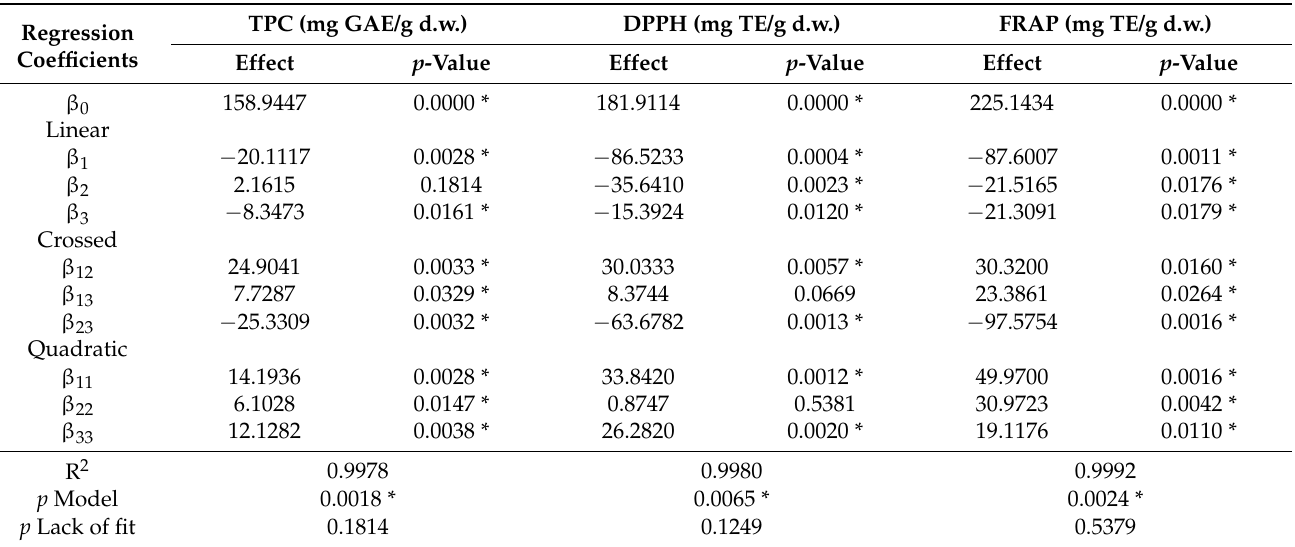
Table 2. Estimated regression coefficients of the adjusted second-order polynomial equation (Equation (1)) and analysis of variance (ANOVA) of the model.